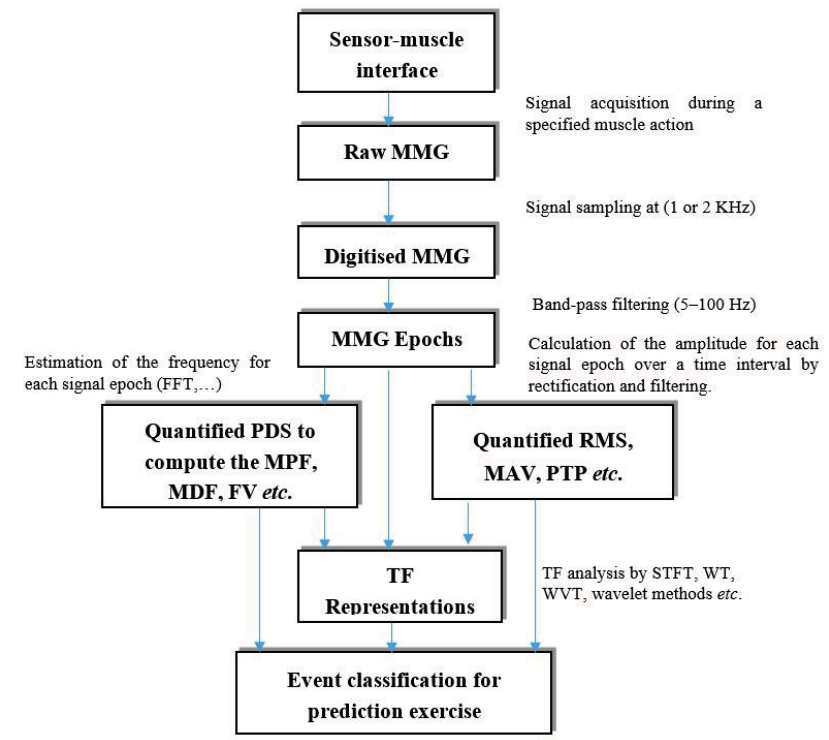
Figure 1. Basic steps in MMG parameters